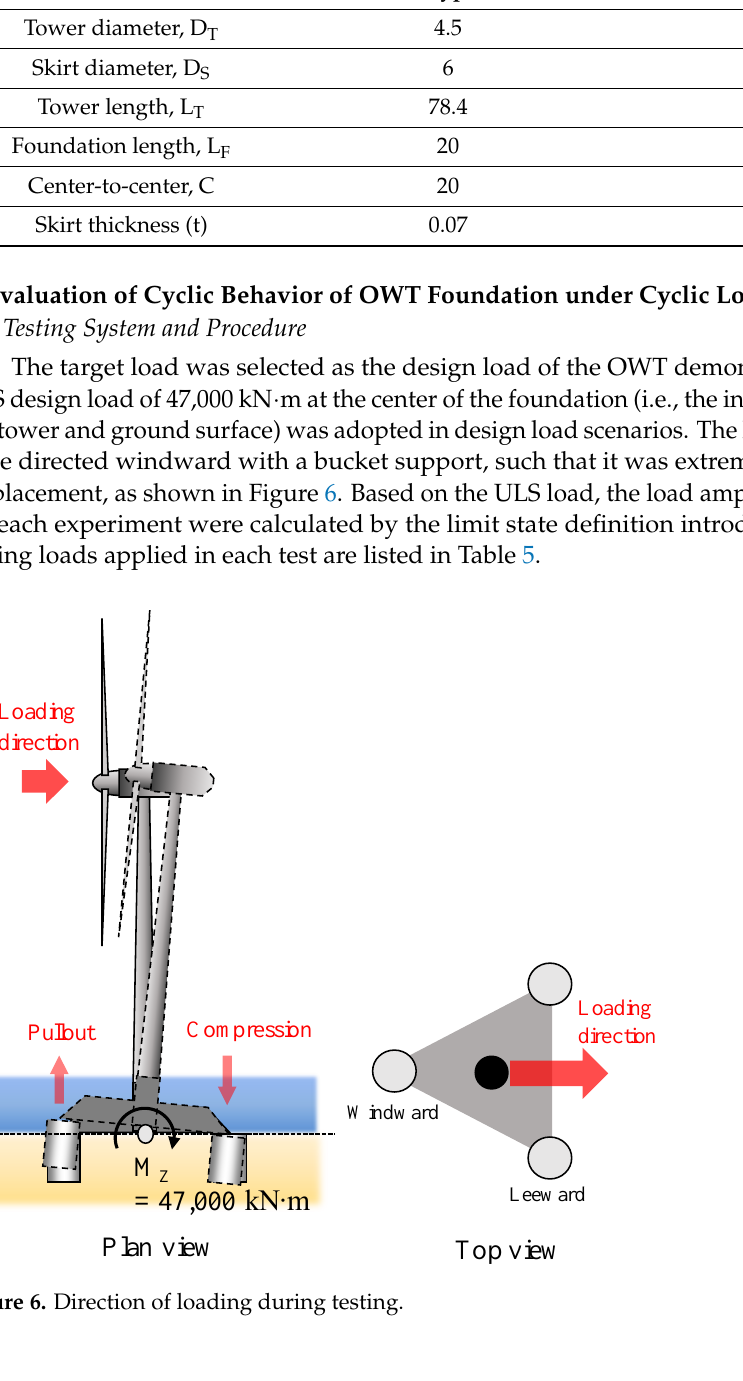
Table 4. Dimensions of the OWT model and prototype.